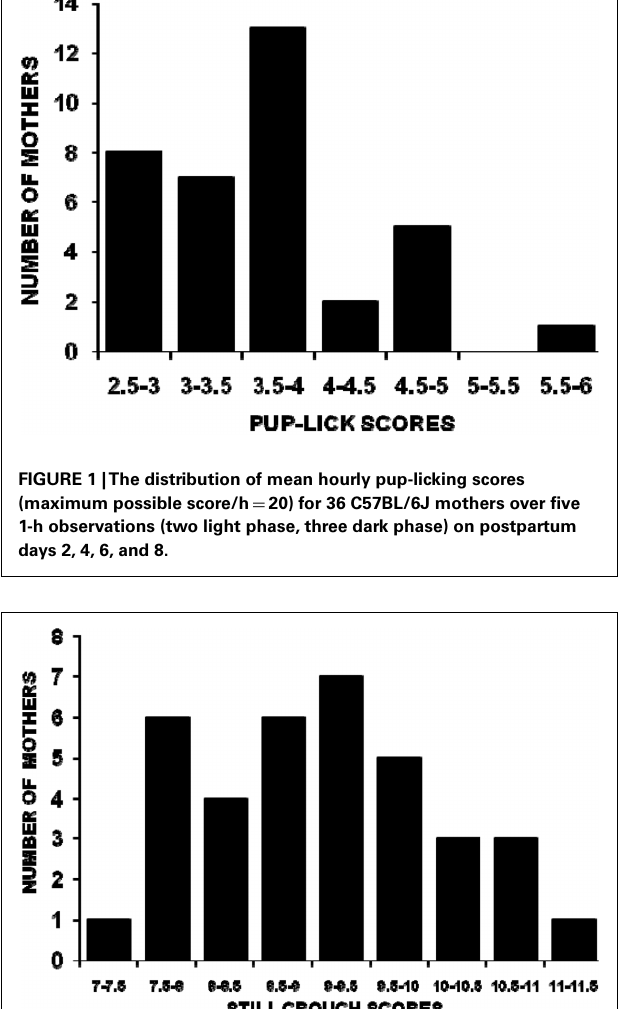
FIGURE 2 |The distribution of mean hourly still crouch nursing scores (maximum possible score/h = 20) for 36 C57BL/6J mothers over five 1-h observations (two light phase, three dark phase) on postpartum days 2, 4, 6, and 8.